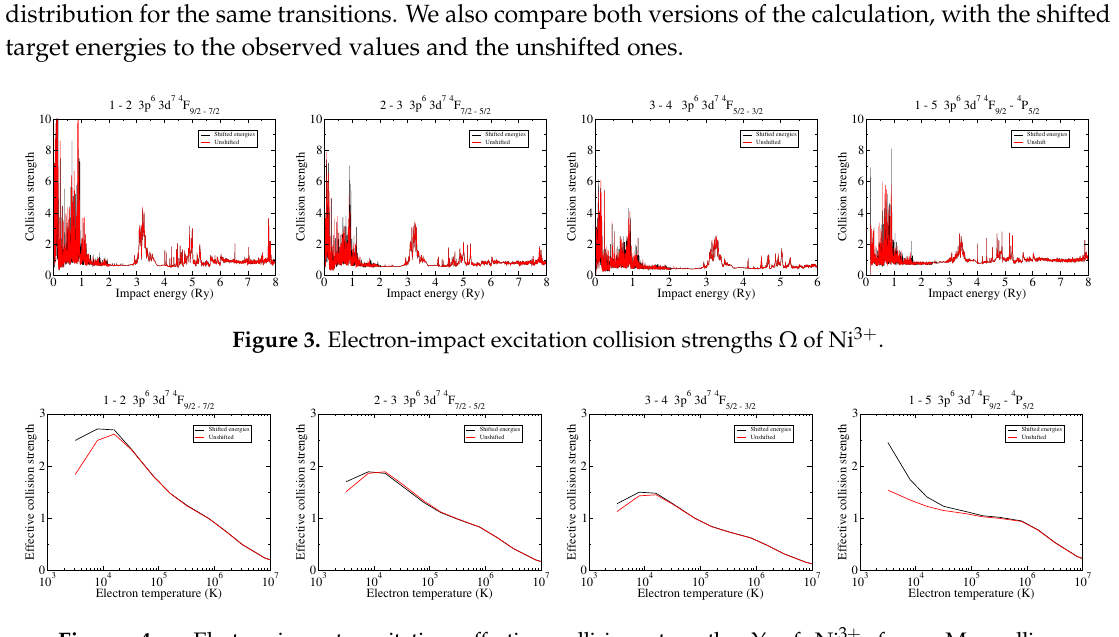
Figure 4. Electron-impact excitation effective collision strengths Υ of Ni 3 + for a Maxwellian electron